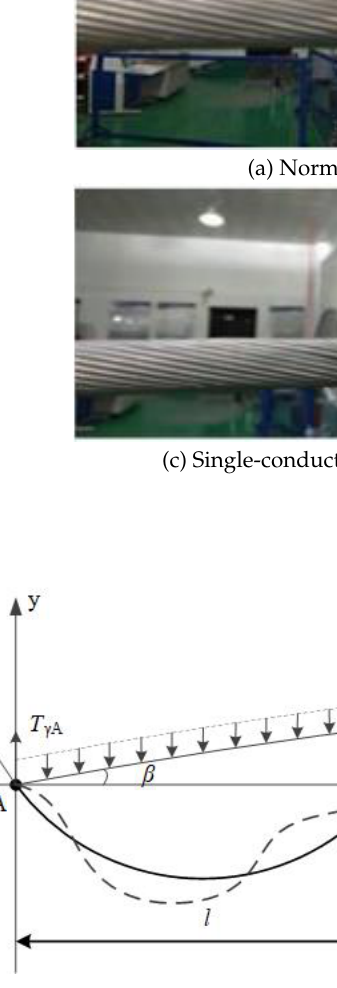
Fig. 3. Force state of the positive feeder when galloping